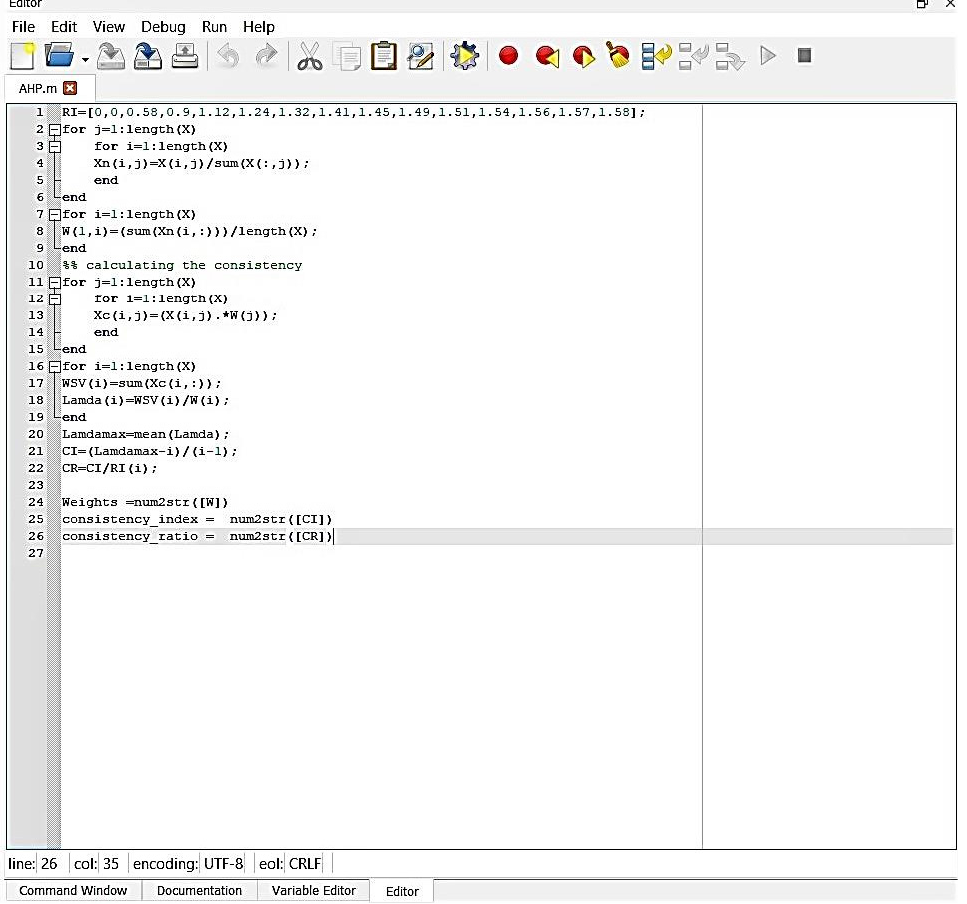
Figure A1. The code of the GNU Octave tool.